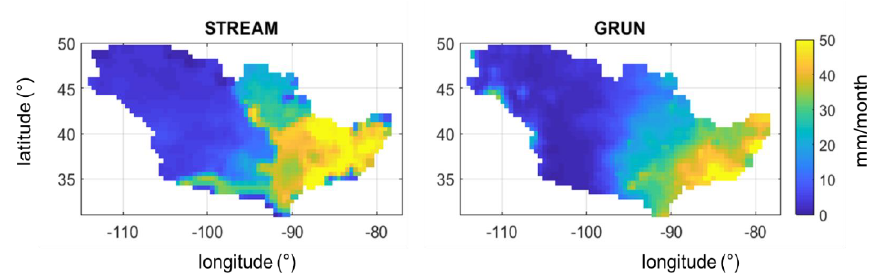
Figure 6. Mississippi River basin: mean monthly runoff for the period 2003–2014 obtained by STREAM and GRUN models.